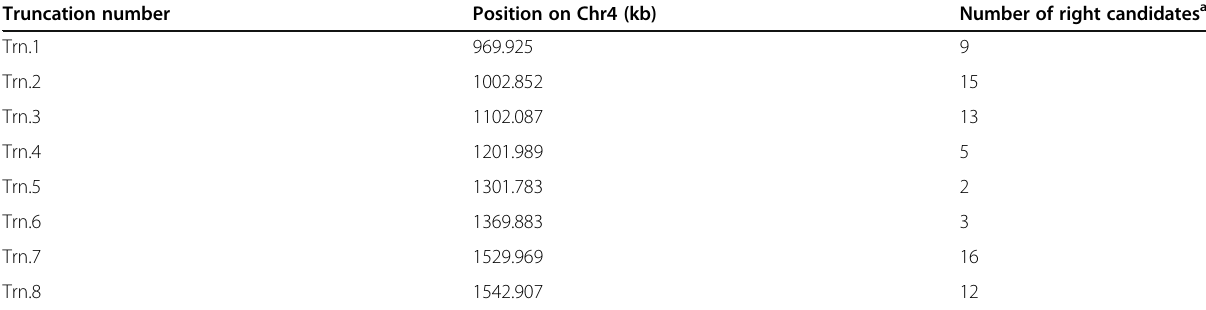
Table 3 Candidates obtained after PCR screening and CHEF verification Truncation number Position on Chr4 (kb)